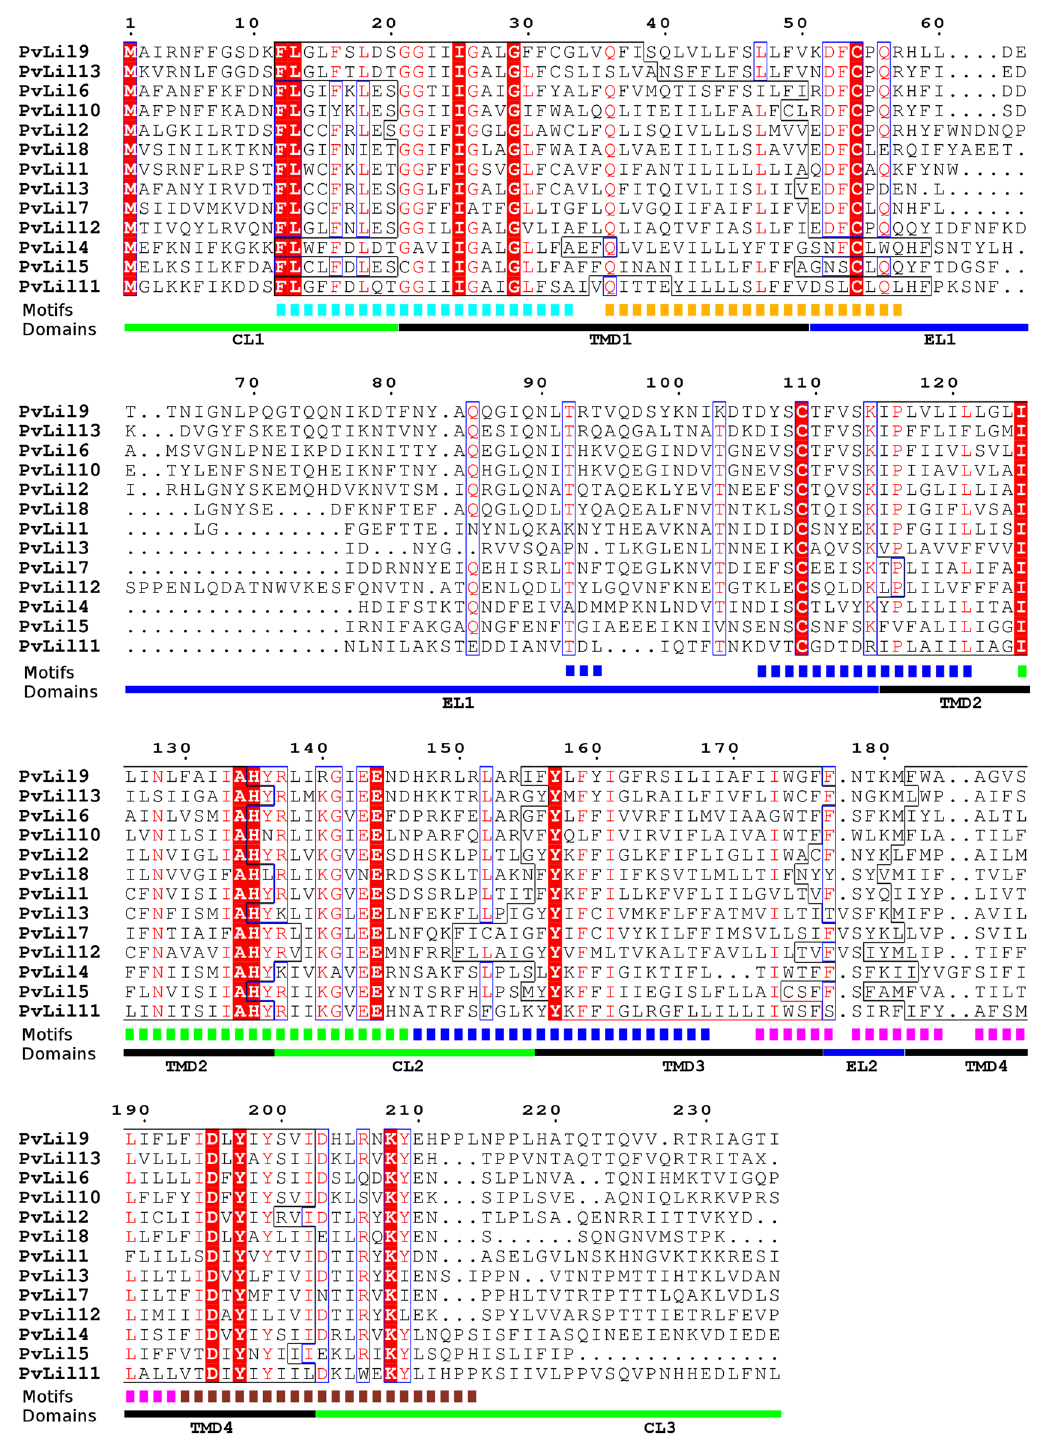
Figure 6. Distribution of domains and motifs across PvLIL sequences. Red highlighting and red coloured letters on alignment indicate amino acid residues with 100% and ≥ 70% conservation, respectively. Coloured dashed and solid lines below alignment depict PvLIL-specific motifs found by MEME. Solid lines below alignment indicate the position of domains predicted by TMpred: black —transmembrane domains (TMDs), green —cytoplasmic loops (CLs), blue —extracellular loops (ELs). The exact position of predicted transmembrane domains within each protein is denoted on alignment by thin black line. Figure prepared in ESPript 3.0 55 from alignment obtained in CLC Genomics Workbench 8.0 (QIAGEN, Denmark). Annotation names were added in GIMP